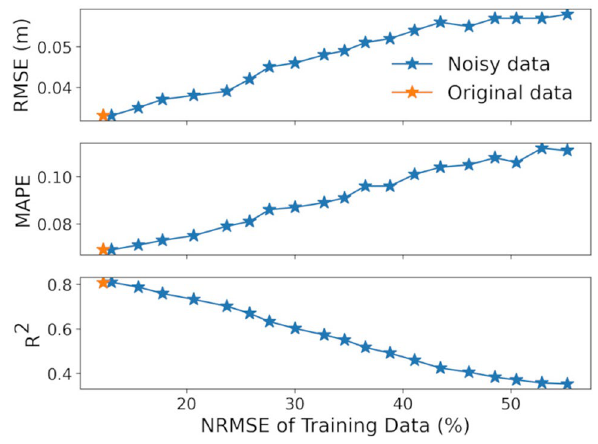
Figure 8. Error evaluation. Performance of motion tracking algorithm trained on noisy data with different normalized root mean square error (NRMSE)